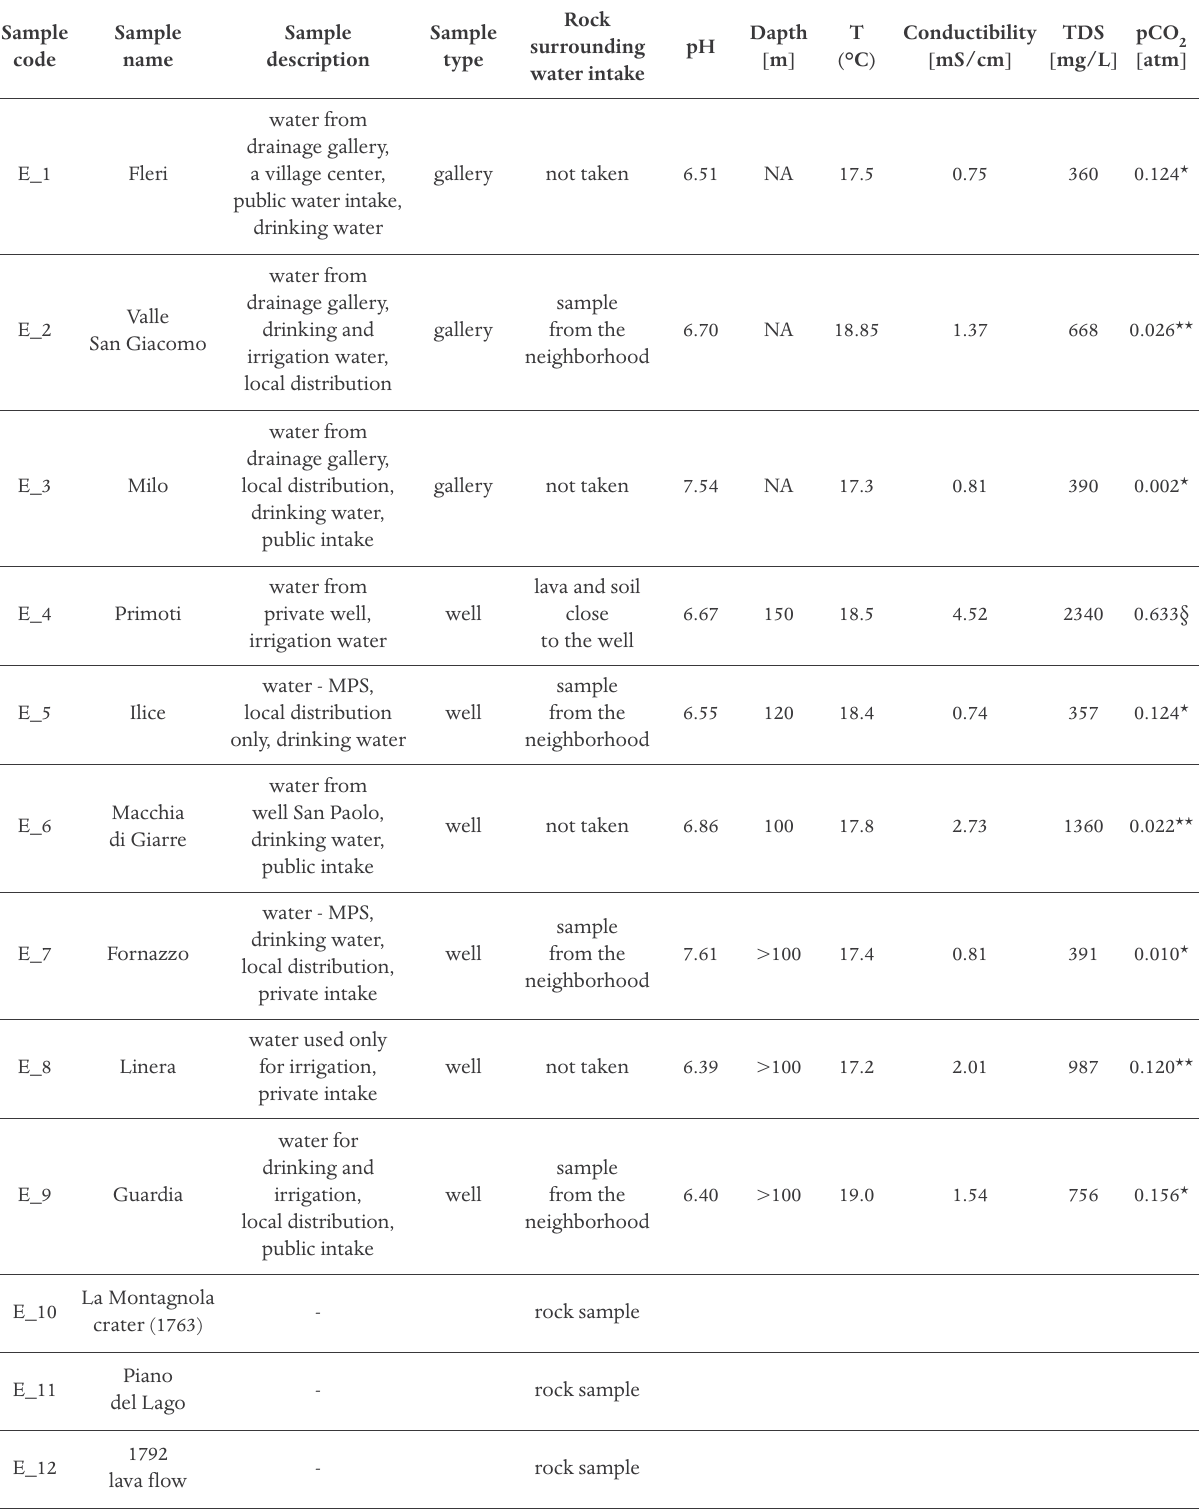
Table 1. Physical-chemical properties of investigated waters and samples description. NA=not available; MPS=municipal power supply; values from Parello et al. [2001]; **pCO *pCO 2 et al.